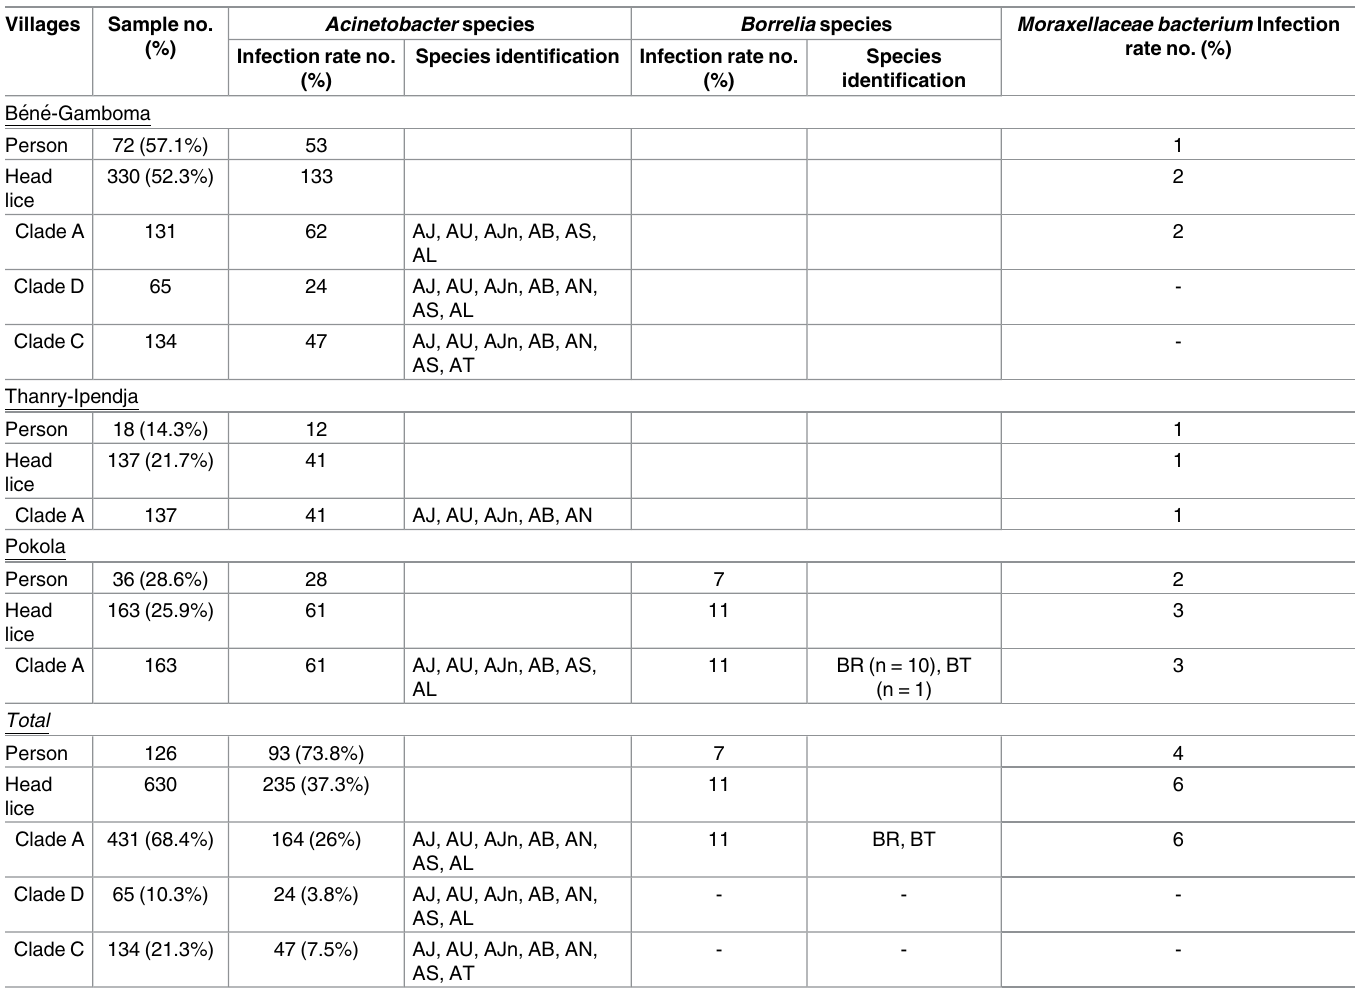
Table 4. Detection of head lice clades and pathogens in the pygmy population in Congo-Brazzaville. Villages Sample no.